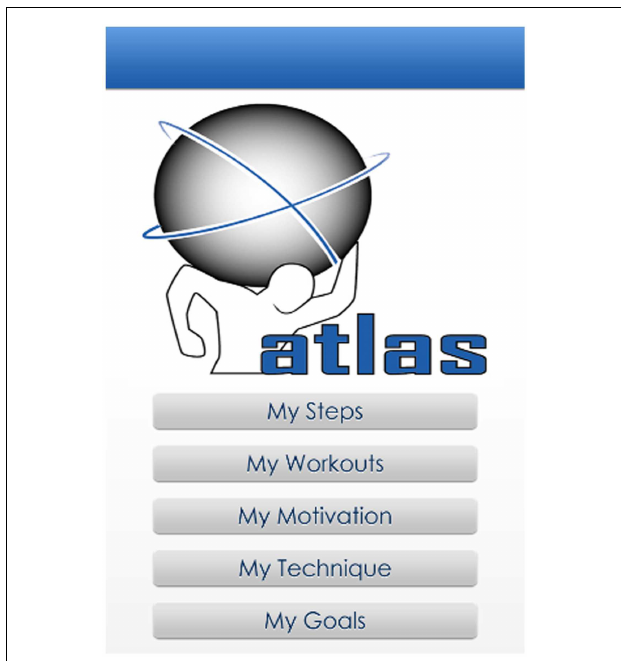
FIGURE 1 |ATLAS app welcome screen